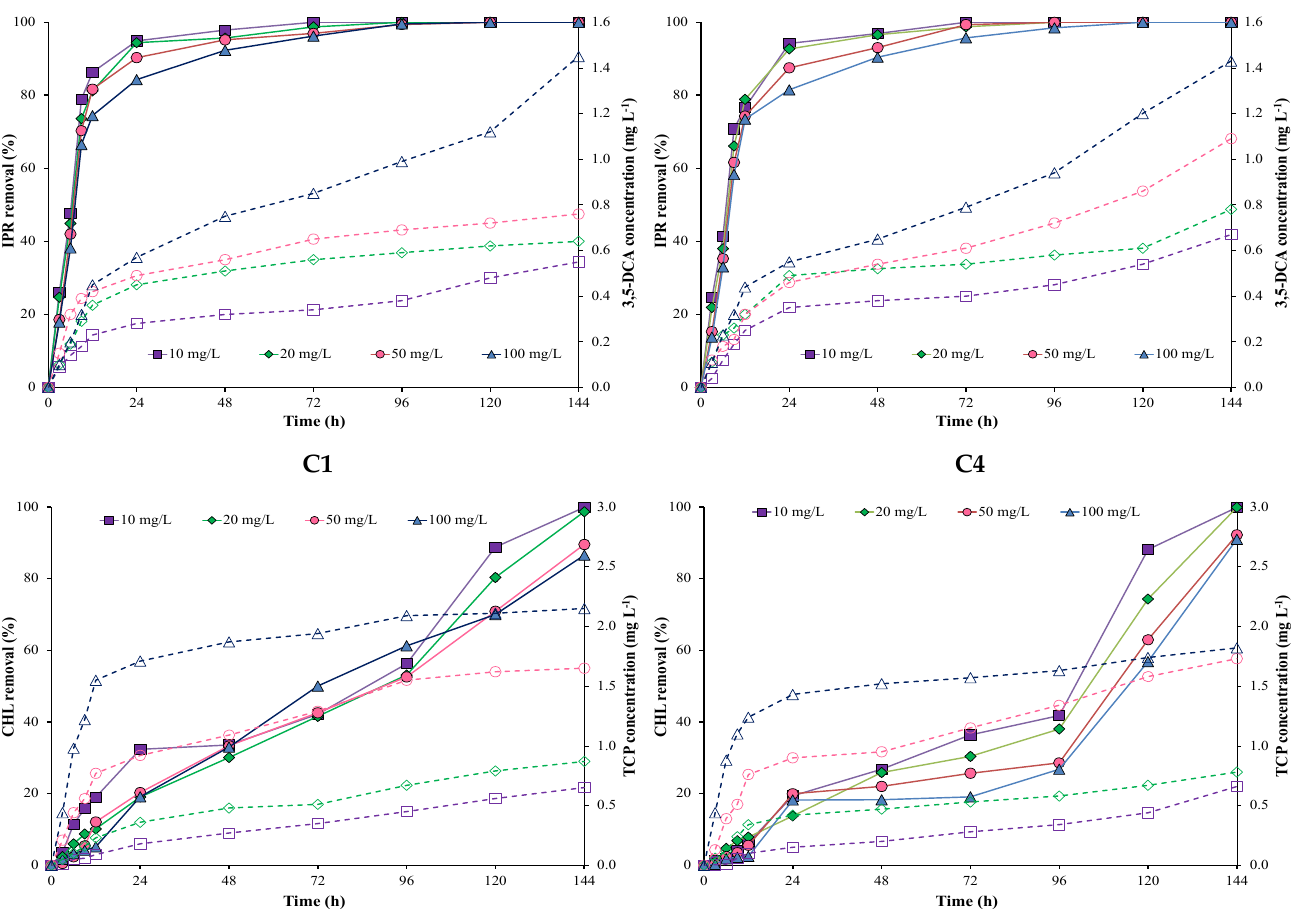
Figure 1. Pesticide removal (symbol filled with a continuous line) and metabolite production (empty symbol with a dotted line) when using individual A. spanius C1 ( left ) and P . rhodesiae C4 ( right ) strains in a liquid medium. Iprodione (IPR) and chlorpyrifos (CHL) were added (in mixture) at concentrations of 10, 20, 50, and 100 mg L − 1 each.